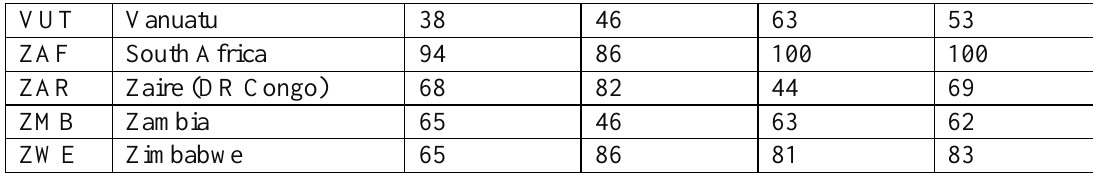
Table 2. Indices of Colonial Transformation (Continued)